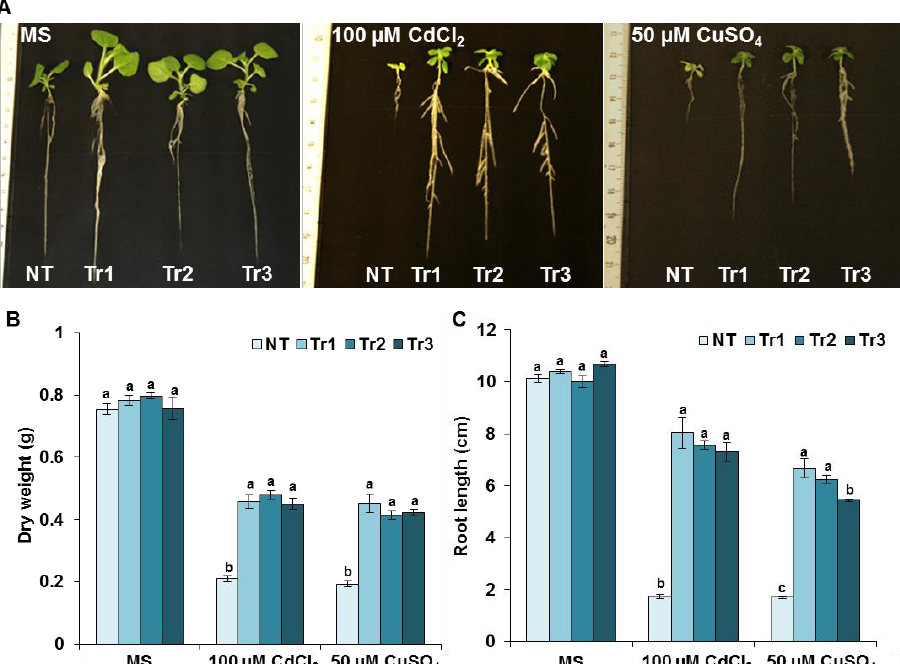
Figure 4. Response of LmTrxh2 tobacco lines and NT plants to heavy metal (Cd and Cu) stress conditions. ( A ) The phenotype of LmTrxh2 transgenic lines, and the dry weight ( B ) and root length ( C ) of the NT and transgenic tobacco lines grown under control and stress conditions for 15 days. The means denoted by the same letter did not differ significantly at p < 0.05.